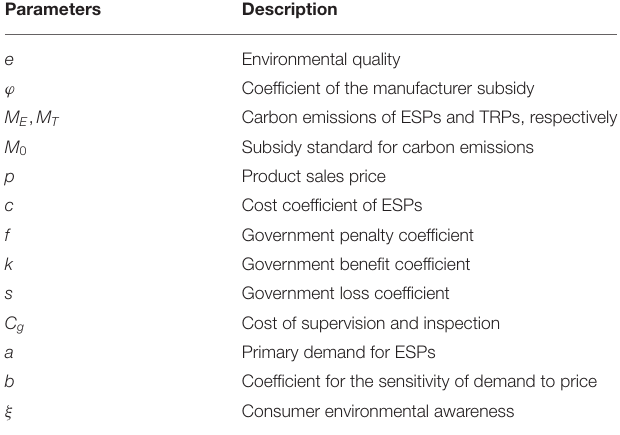
TABLE 1 | The parameters of the game model.